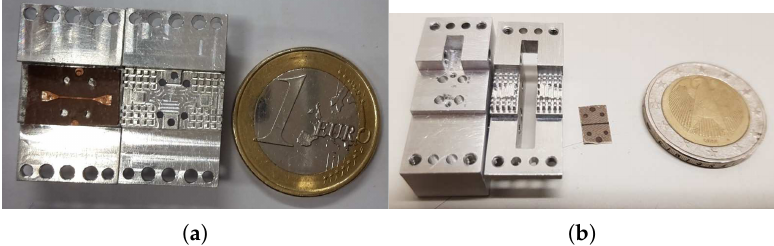
Figure 9. Photographs of the fabricated structures: ( a ) top view of the first transition model aluminum block and microstrip circuit and ( b ) perspective view of the second transition model aluminum block and microstrip circuit.